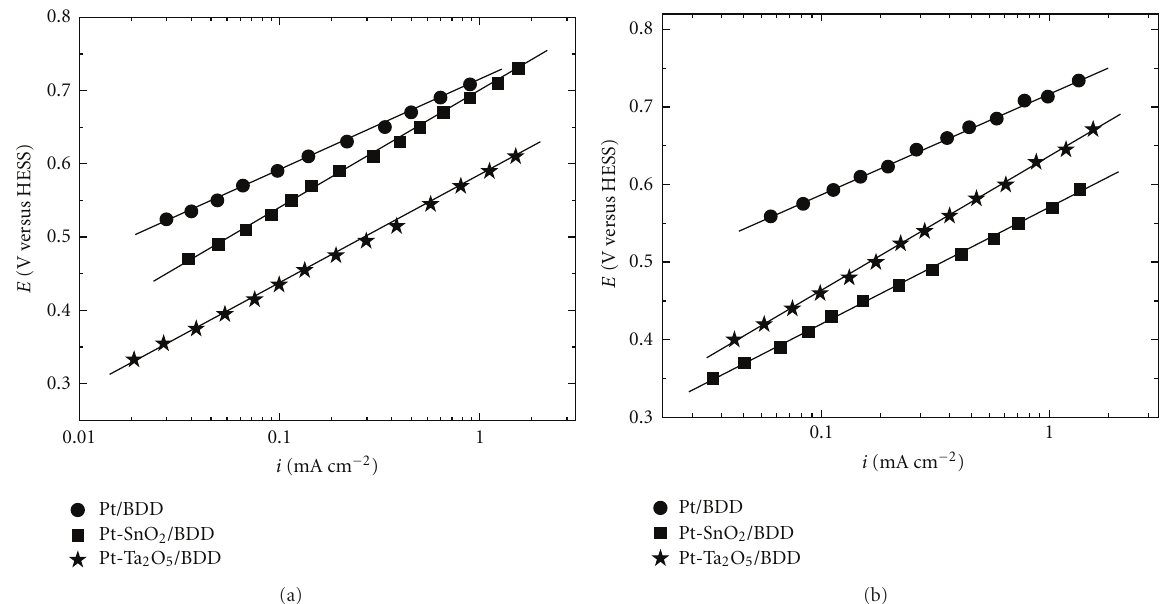
Figure 12: Steady-state polarization curves plotted as the corresponding Tafel plots for the electrochemical oxidation of methanol 0.5 M (a) and ethanol 0.5 M (b) dissolved in 0.5 M H 2 SO 4 and recorded for the Pt/BDD (spheres), Pt-SnO 2 /BDD (squares), and Pt-Ta 2 O 5 /BDD (stars) electrode surfaces (reprinted with permission from [61]).